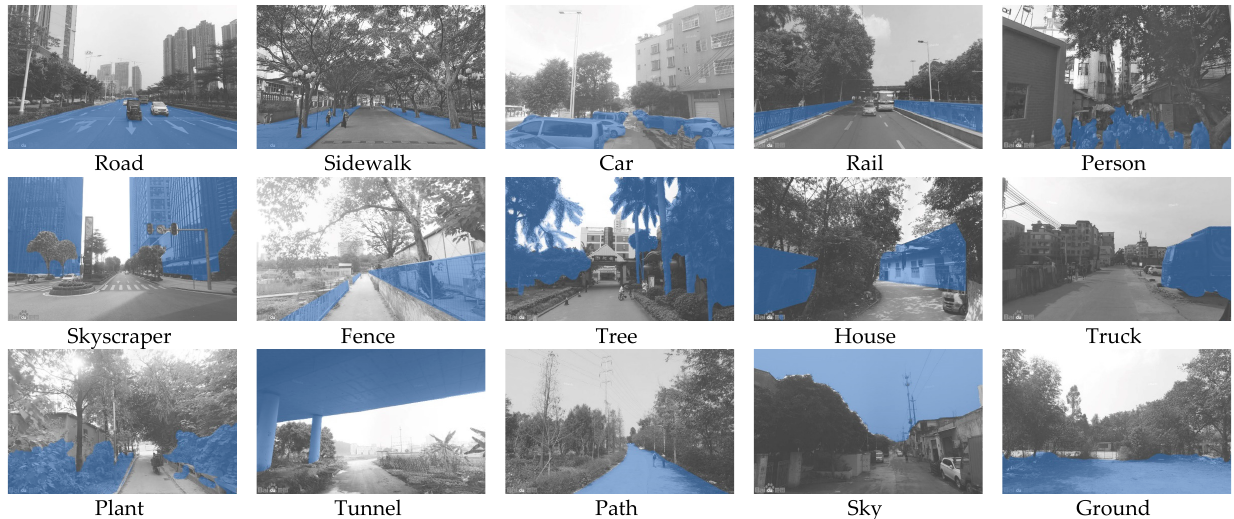
Figure A2. Fifteen visual elements that affect perceived safety.